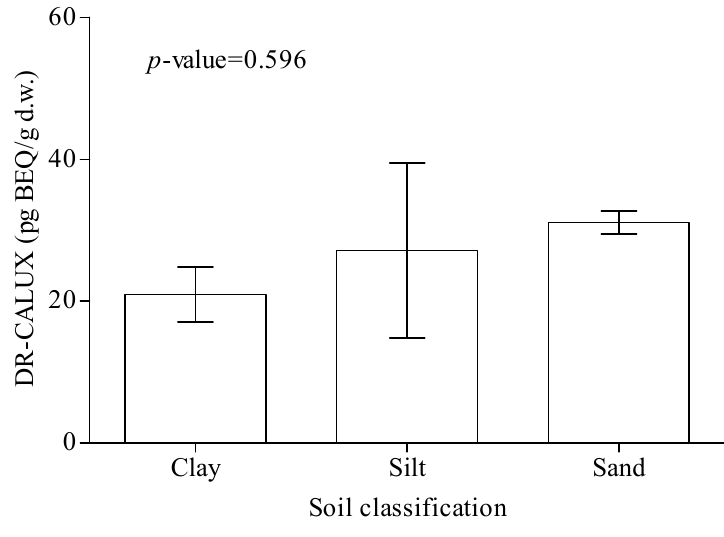
Figure 5. Dioxin concentrations in Taiwanese soil depend on land use (n = 685). The dioxin concentration in soil used for food production near an industrial area is notably higher than that in soil from the other areas ( p < 0.01 or p < 0.001). Soil dioxin levels in parks near residential areas, industrial areas, and wasteland areas are significantly higher than those in land used for other purposes ( p <